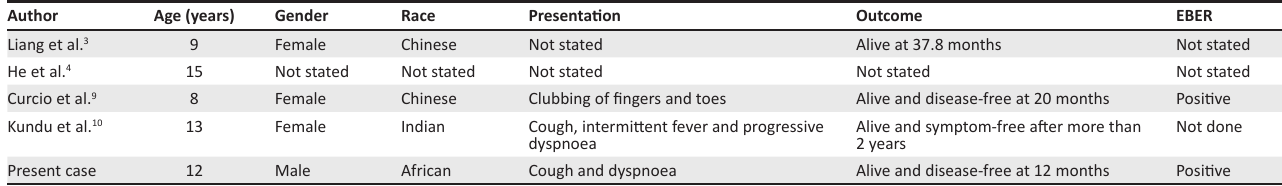
TABLE 1. Reported cases of paediatric pulmonary lymphoepithelioma-like carcinoma.